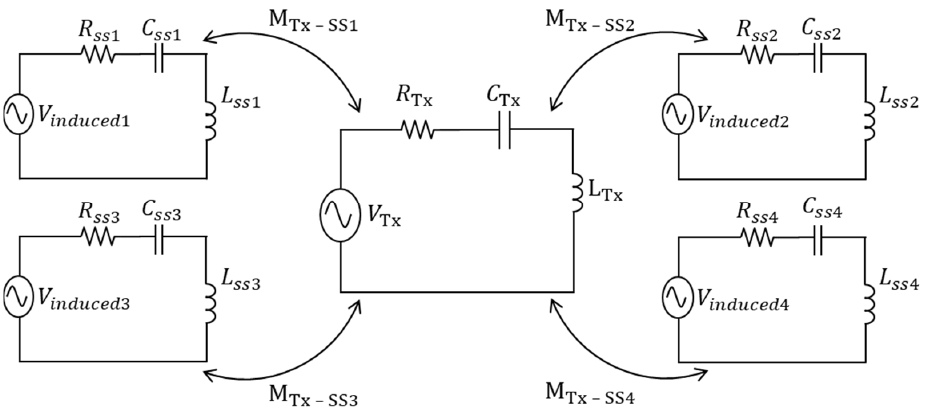
Figure 3. Equivalent circuit of the proposed WPT system before the receiver enters.